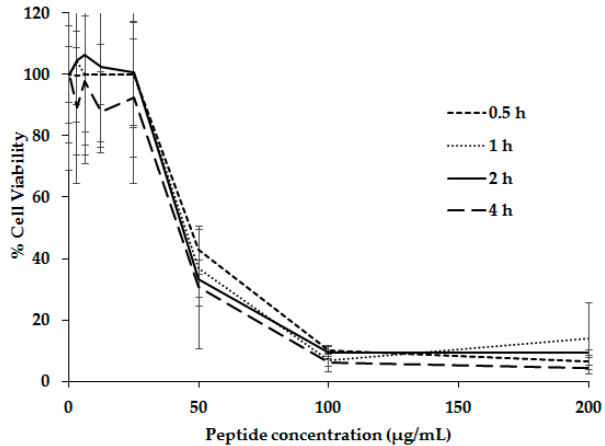
Figure 4. Cytotoxic effect of peptide LfcinB (20–25) 4 against MDA-MB-468 cell line. Cells were treated with different peptide concentrations and different incubation times.